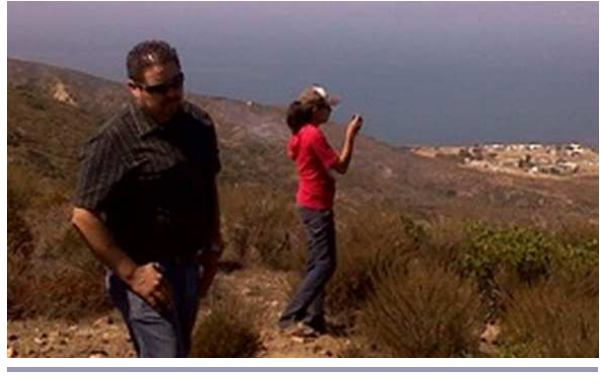
Fig. 9. Observation work in the ejido.